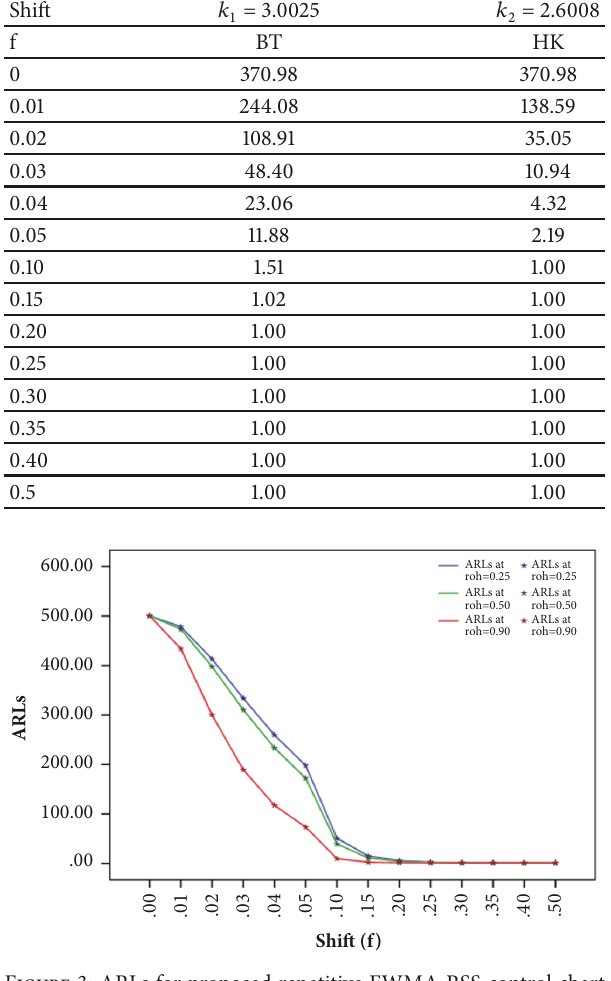
Figure 3: ARLs for proposed repetitive EWMA-RSS control chart using Bahl and Tuteja (1991) estimator, when 𝑟 𝑜 = 500 at 𝜆 = 0.3.